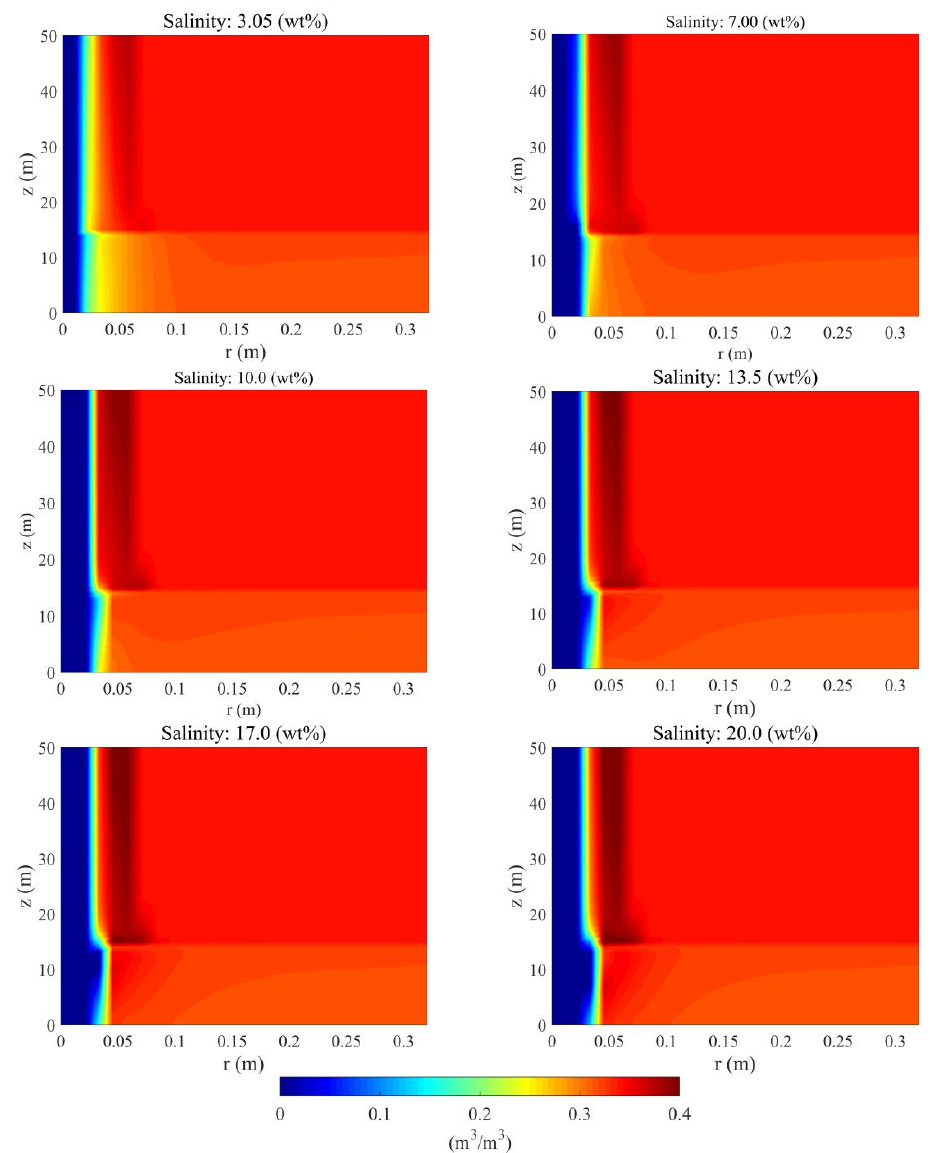
Figure 14. Comparison of two-dimensional hydrate saturation distribution of hydrate reservoirs for a fixed temperature of 16 °C at the 24th hour of drilling fluid invasion under various drilling fluid salinity values.